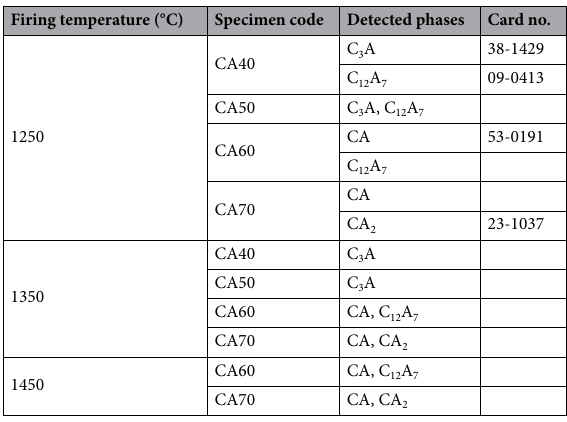
Firing temperature (°C) Specimen code Detected phases Card